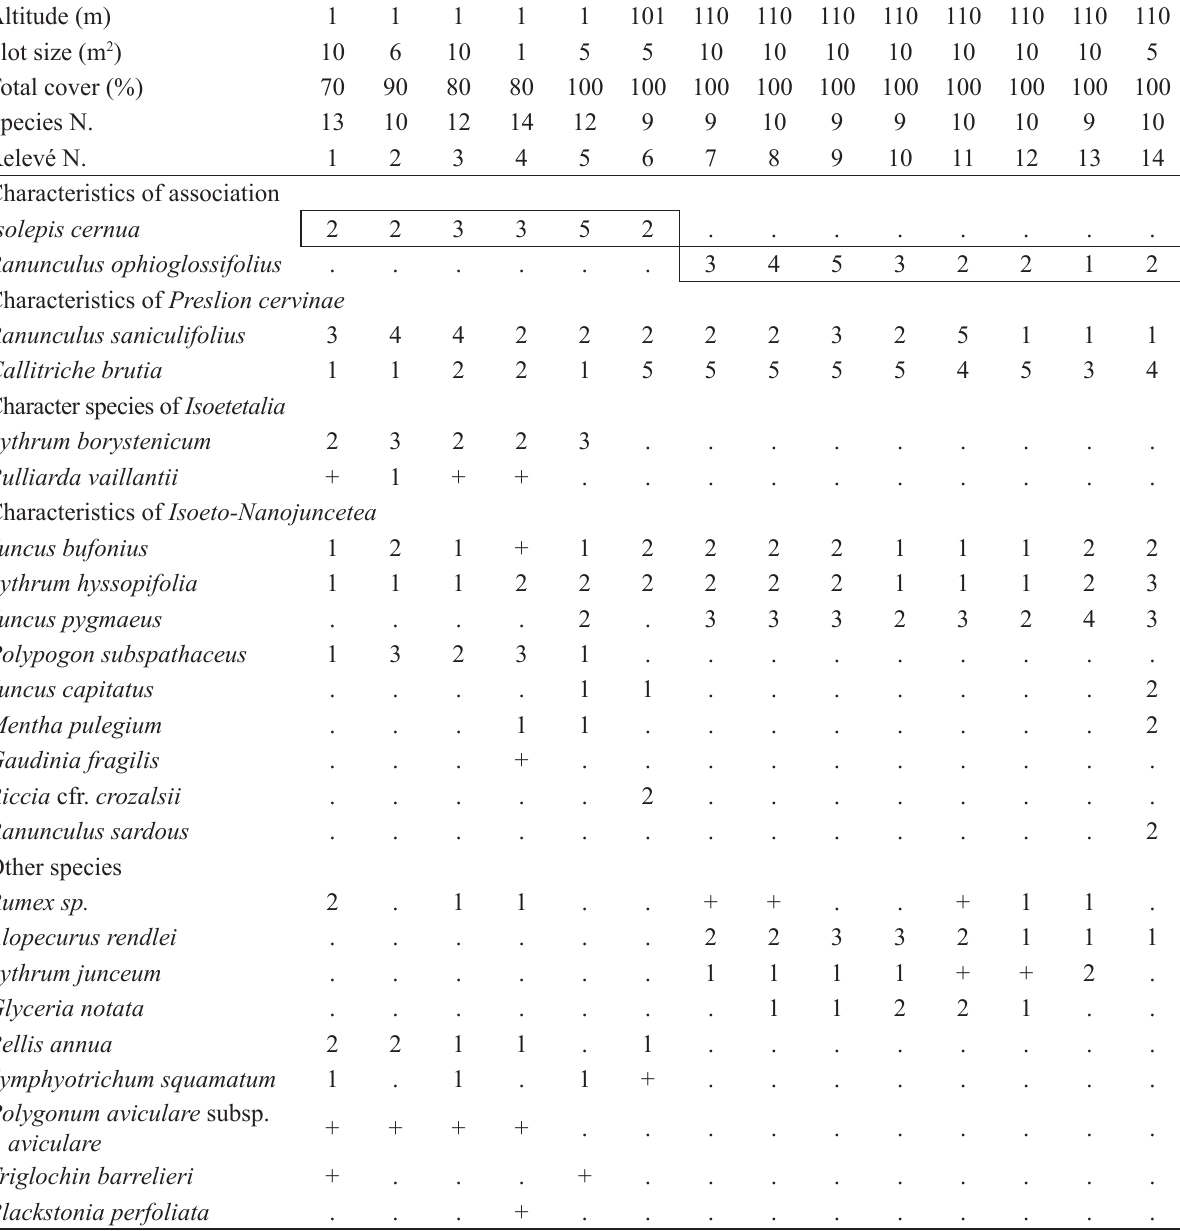
Table 2. Isolepido cernuae-Ranunculetum saniculifolii ass. nova (rel. 1-6); Ranunculo ophioglossifolii-Callitrichetum brutiae ass. nova (rel. 7-14) ( Preslion cervinae , Isoetalia , Isoeto - Nanojuncetea ) Altitude (m)